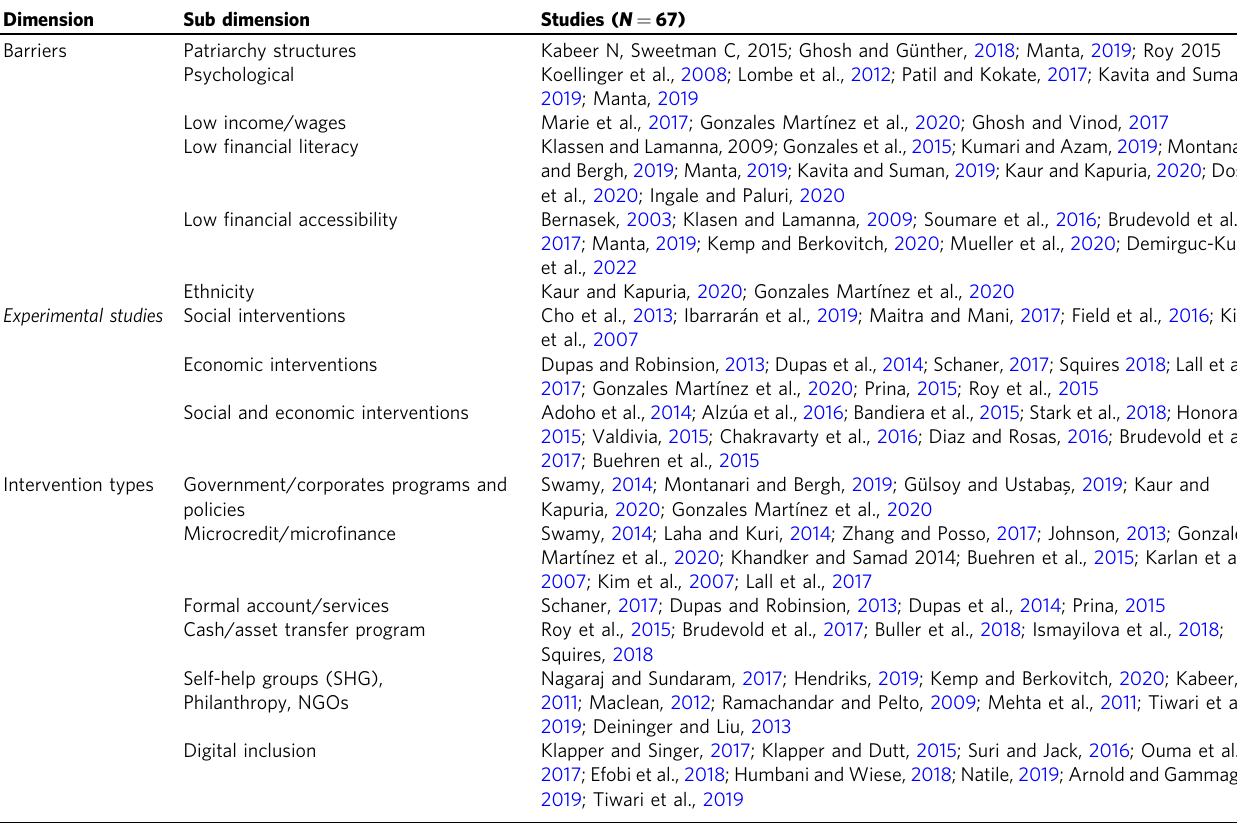
Table 3 Dimensions or themes of FI and women empowerment.